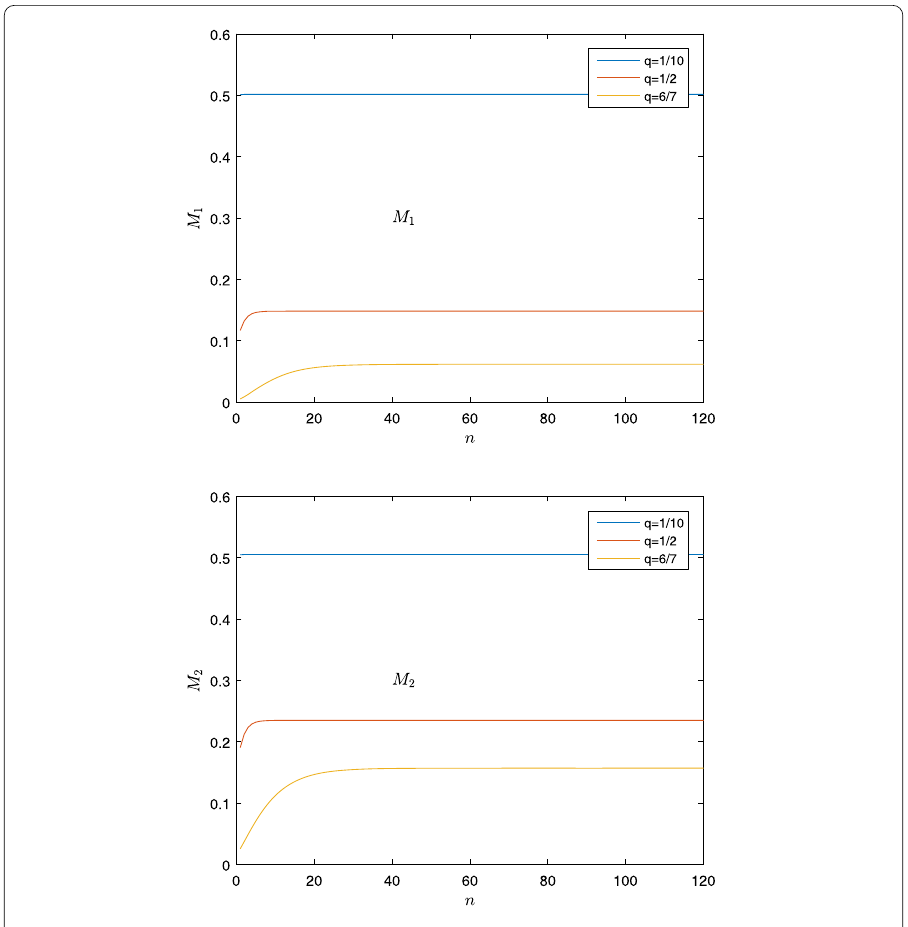
Figure 1 Numerical results of M 1 and M 2 where q = 1